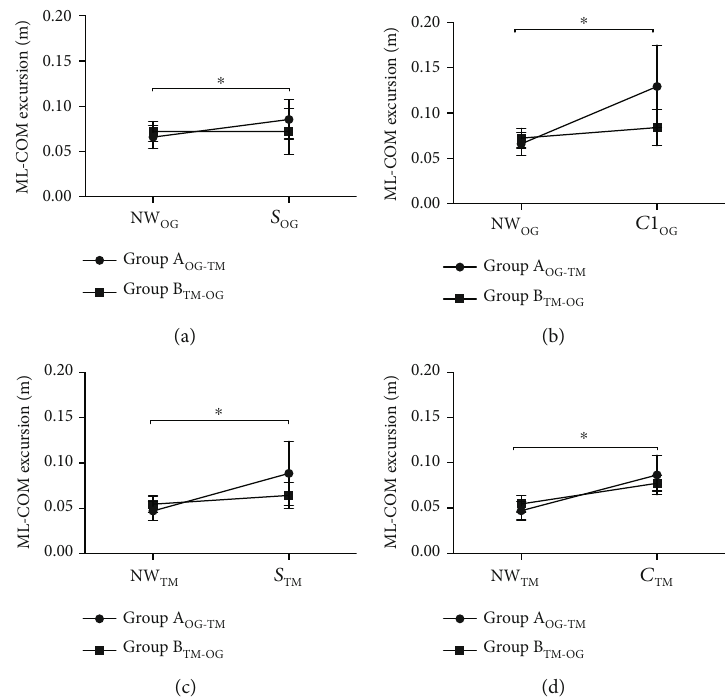
Figure 5: Comparative analysis of the ML-COM excursion in response to the fi rst exposure to the VRE for both over-ground and treadmill surface conditions. (a) Mean and SD of the ML-COM excursion for the fi rst natural walking (NW during over-ground walking. (b) Mean and SD of the COM excursion angle for the fi rst natural walking (NW ( C ) VRE trial during over-ground walking. (c) Mean and SD of the ML-COM excursion for the fi rst natural walking (NW OG fi rst snowy ( S ) VRE trial during treadmill walking. (d) Mean and SD of the ML-COM excursion for the fi rst natural walking (NW TM and the fi rst crowded ( C ) VRE trial during treadmill walking. Signi fi cant changes between trials ( p < 0 : 05 ) are indicated by ∗ TM